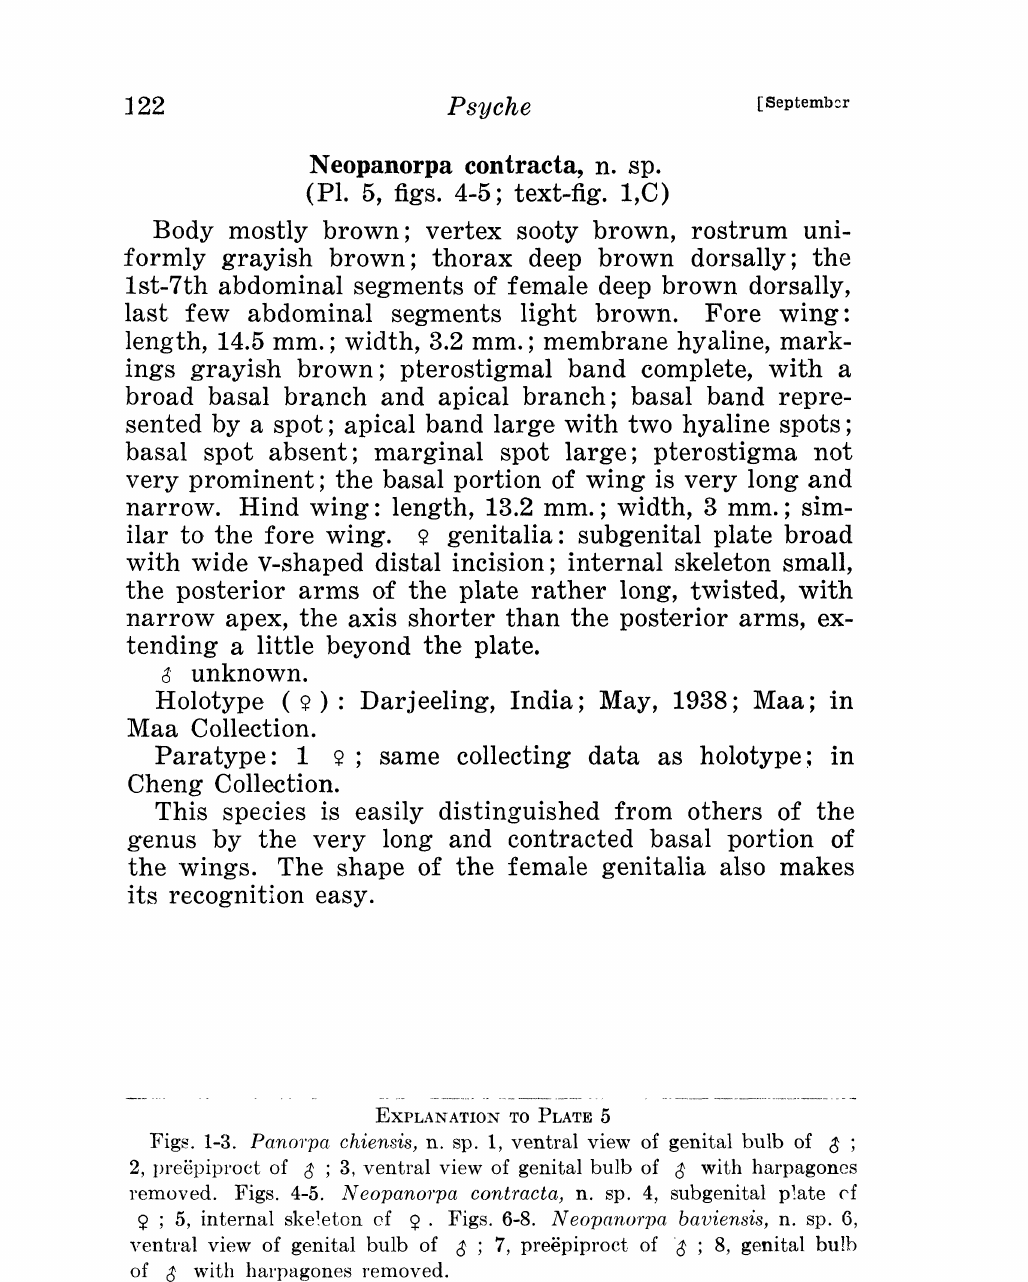
Figs. 1-3. Panorpa chiensis, n. sp. 1, ventral view of genital bulb of